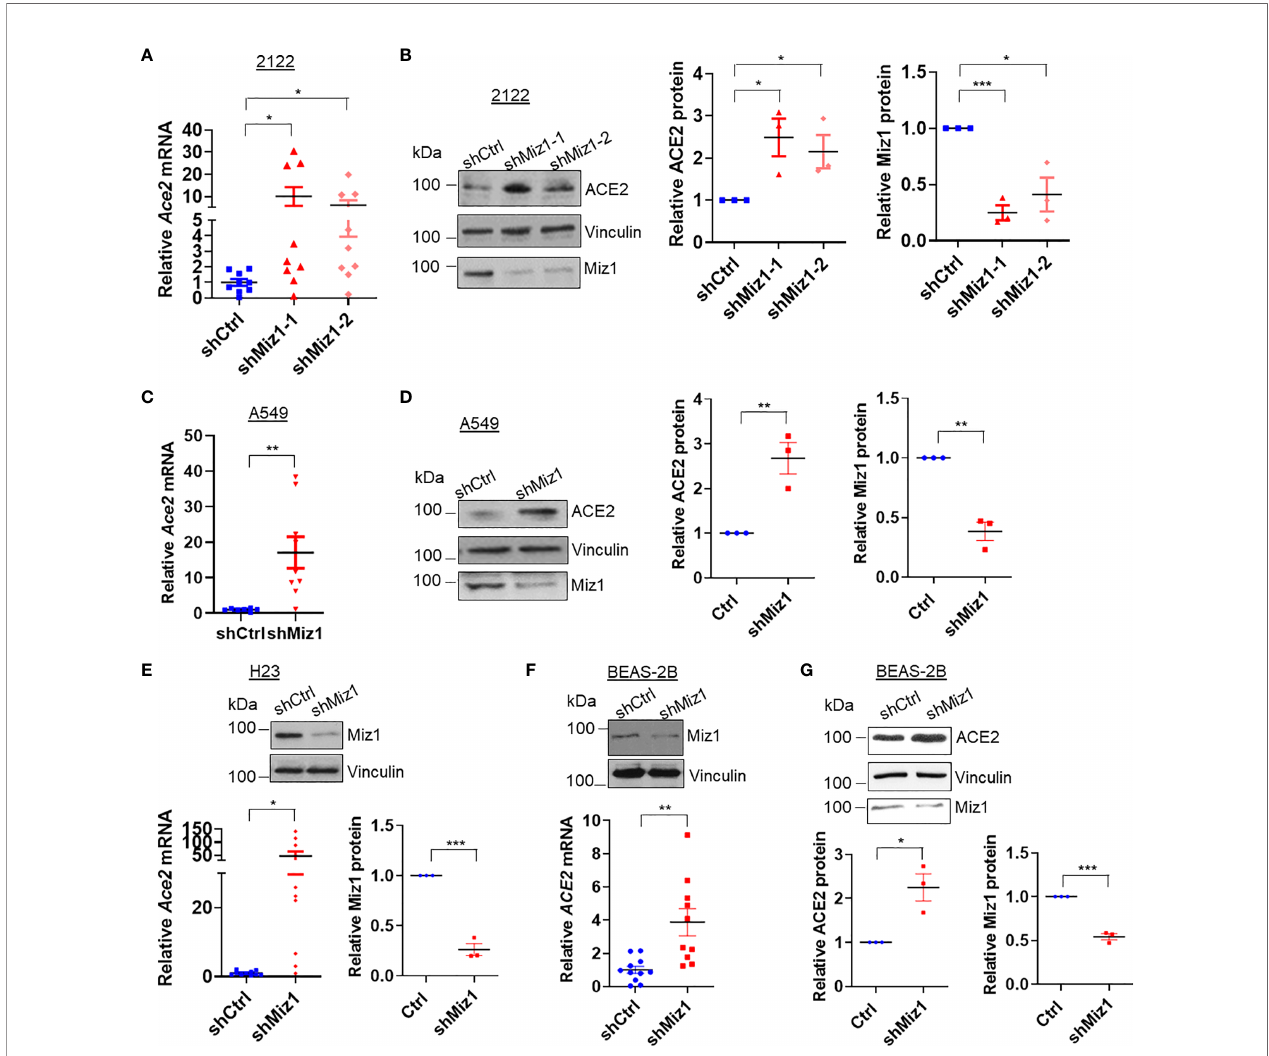
FIGURE 5 | Knockdown of MIZ1 also increases ACE2 expression in human lung epithelial cells. (A, C, E, F) ACE2 mRNA levels in the parental 2122, A549, H23, or BEAS-2B cells, or their corresponding cells expressing control shRNA (shCtrl) or shRNA(s) against Miz1 (shMiz1). (B, D, G) Protein expression of ACE2, Vinculin, and Miz1 in 2122, A549, or BEAS-2B cells stably expressing shCtrl or shRNA(s) against Miz1. Data are presented as means ± sem from three independent experiments. * p < 0.05, ** p < 0.01 and *** p <